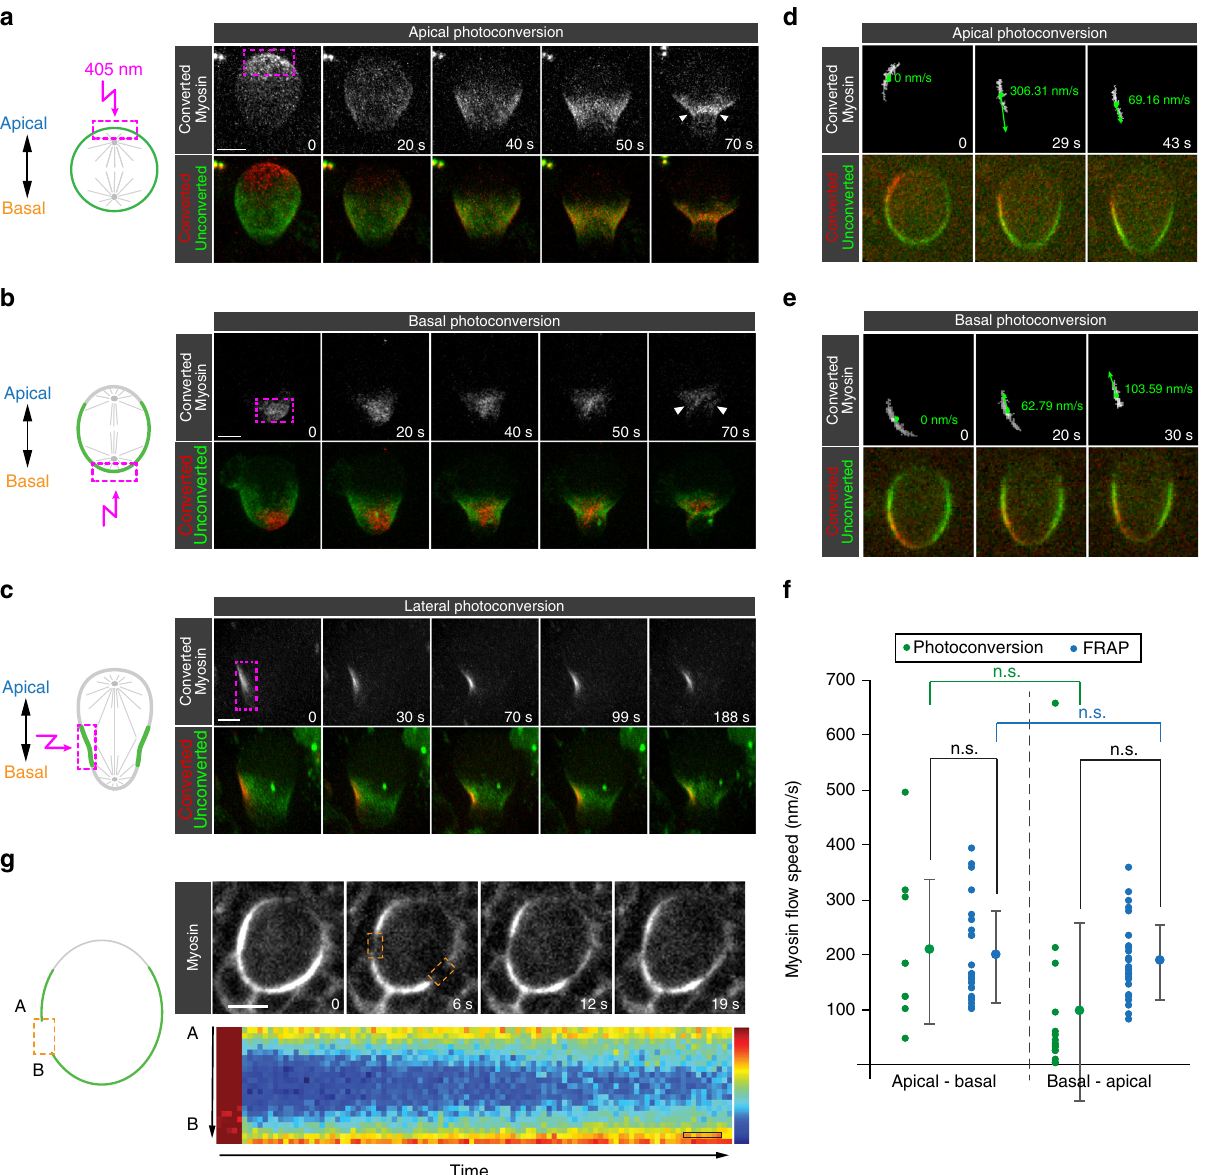
Fig. 2 Myosin relocalizes to the cleavage furrow through cortical fl ow. Myosin::Dendra2 was photoconverted on the ( a ) apical, ( b ) basal and ( c ) lateral neuroblast cortex. Top row: maximal projection of photoconverted Myosin. Bottom row: overlay between non-photoconverted (green) and photoconverted Myosin (red), shown in maximal projection. The purple dashed box represents the photoconverted ROI. d Representative wild-type neuroblasts showing photoconverted Myosin at the apical (top) or e basal cortex (bottom). Top row: maximal projection of photoconverted Myosin. Bottom row: maximal projection showing both non-photoconverted (green) and photoconverted Myosin (red). Myosin fl ow velocity was determined with custom-made software and plotted in f . Center values and error bars represent the mean and standard deviation (s.d), respectively. Asterisks denote statistical signi fi cance, derived from unpaired t tests: * p ≤ 0.05, ** p ≤ 0.01, *** p ≤ 0.001, **** p ≤ 0.0001. Each measured cell (n) is represented with a dot in the scatter plots. For each experiment, the data were collected from at least 3 independent experiments. For each independent experiment, at least 5 larvae were dissected. g Representative wild-type neuroblast expressing Sqh::GFP (Myosin; white). The GFP signal was bleached in two regions of interests (ROIs; orange dashed boxes) and kymographs (shown below the image sequence) were used to measure the recovering fl uorescence. The shown kymograph was derived from the left lateral side as shown in the cartoon. Highest fl uorescence intensity is shown in red, lowest in blue. Time: seconds (s). Scale bar: 5 µ m. Time scale bar (open black box) in (g): 1 s. n.s. not signi fi cant (Fig. 2b, Supplementary Fig. 2m and Supplementary Movie 3). disassemble and redistribute through the cytoplasm, thereby Thus, consistent with the high temporal live cell imaging results, reaching the cleavage furrow. Alternatively, the contractile both pre-anaphase apical and early anaphase basal Myosin properties of the actomyosin cytoskeleton could induce the molecules contribute to the forming contractile ring. onset of fi rst an apical — basal (basal directed) and subsequently a basal — apical (apical directed) cortical fl ow 27 . To distinguish Myosin fi laments fl ow towards the cleavage furrow region . between these scenarios, we converted Myo::mDendra2 at the Apical and basal cortical Myosin fi laments could locally lateral cortex shortly after apical clearing. If cortical Myosin | DOI: 10.1038/s41467-017-01391-w |